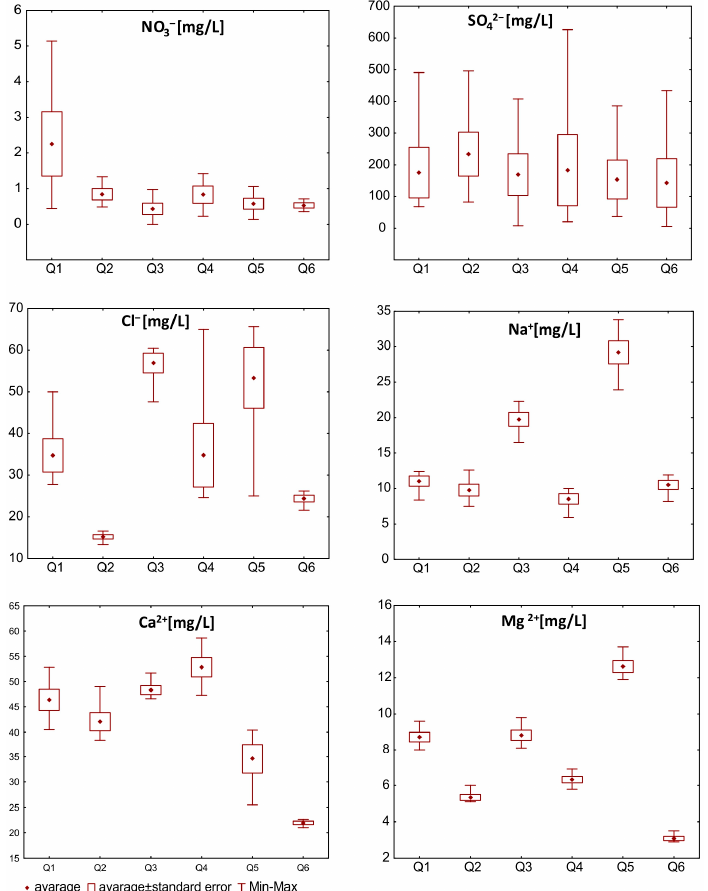
Figure 4. The average and range of variability concentration of selected ions in the water of the analysed Strzelin granitoids quarry lakes (author B.J.).